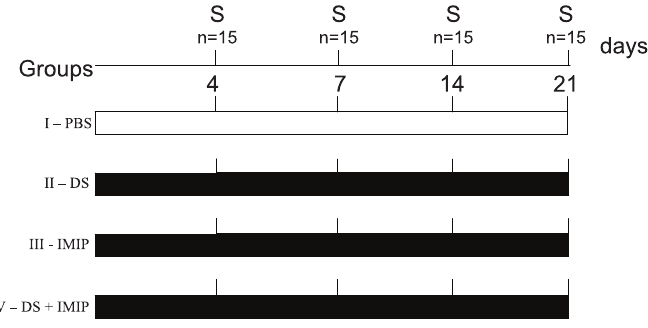
FIGURE 1 - Experimental design. S = sacrifice, PBS = phosphate buffered saline (physiological solution), n = number of animals, IMIP = Imipenen, DS = Diclofenac